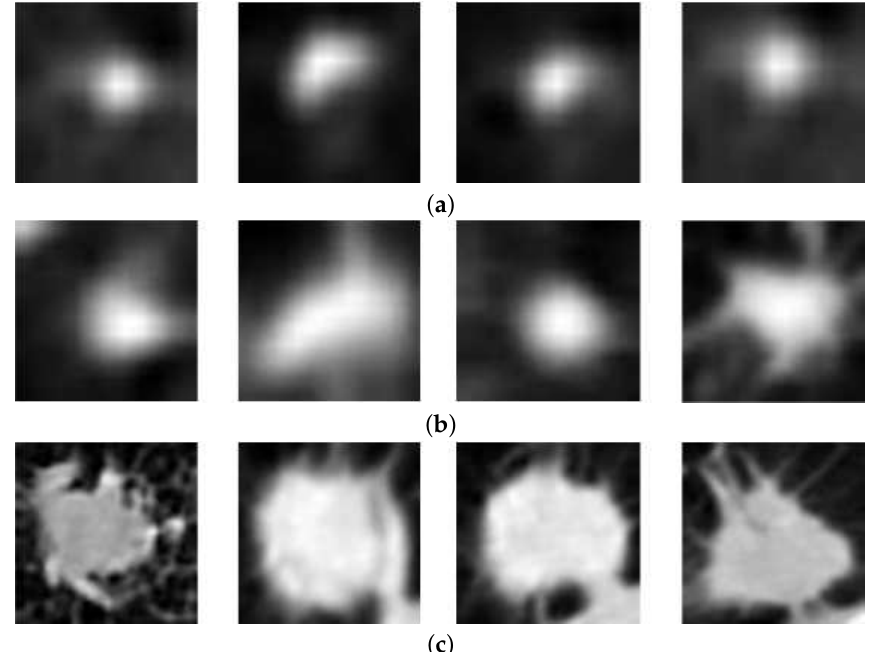
Figure 1. Samples for three classes: ( a ) benign nodules; ( b ) indeterminate nodules; and ( c ) malignant